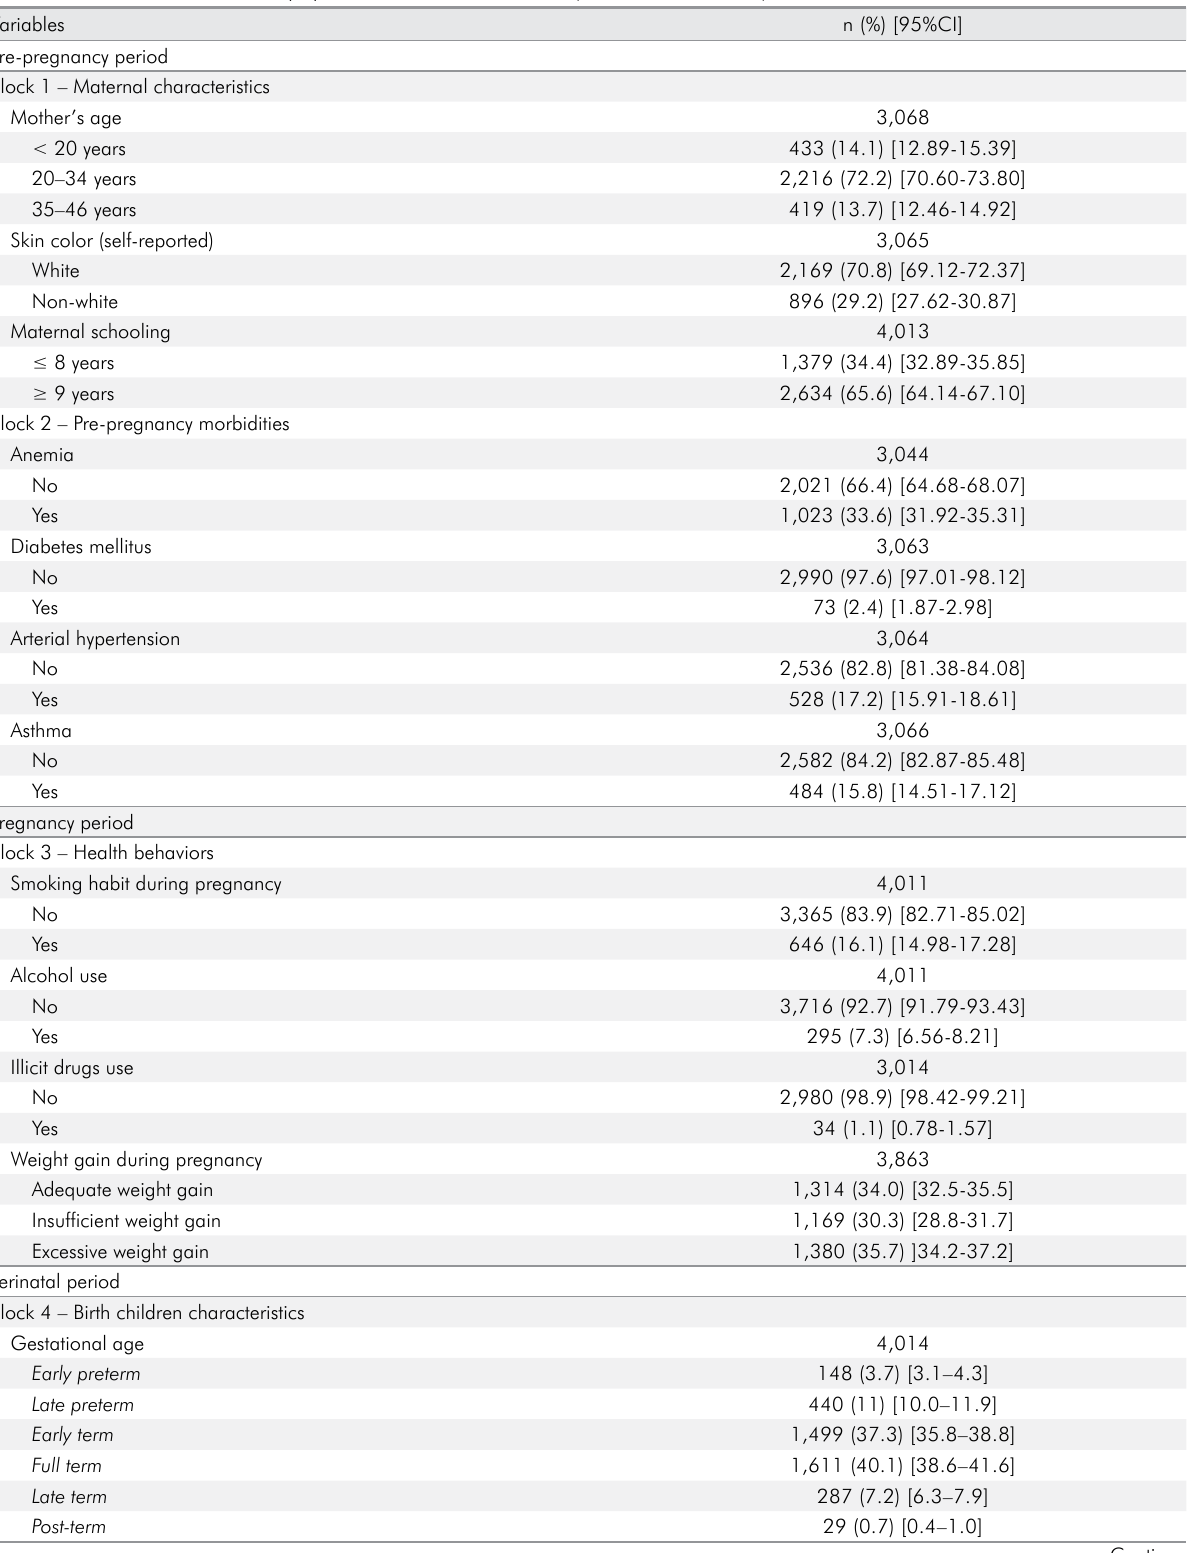
Table 1. Descriptive analysis of total sample considering socioeconomic and demographic characteristics, anthropometric measures and health behaviors in children population. Pelotas, RS, Brazil (n = 4,014